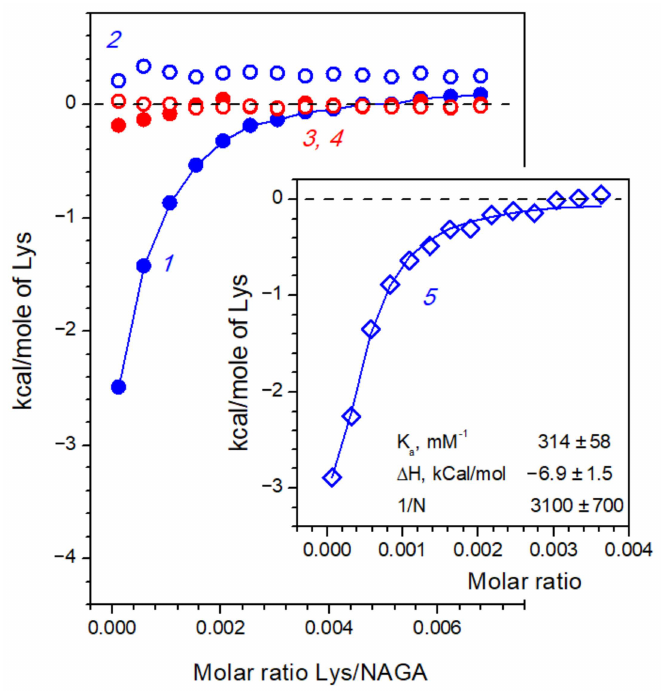
Figure 3. PNAGA binds lysozyme at 10 ◦ C (blue circles) but does not bind it at 25 ◦ C (red circles). ITC data for titration of polymer solutions with lysozyme solutions (curves 1 and 3, filled circles) and buffer solutions (curves 2 and 4, empty circles). The inset represents titration with lower molar ratio and the values of binding constant (K a ), enthalpy ( ∆ H), and stoichiometry (1/N, in terms of bound NAGA units per a protein molecule) of the binding. Polymer concentration is expressed in terms of molar concentration of NAGA repeated units. 10 mM phosphate buffer, pH 7.4.